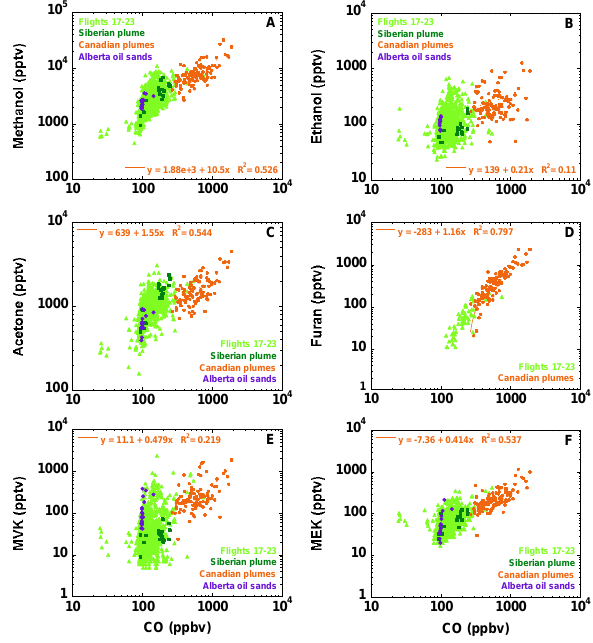
Figure 8. As in Figure 4 but for selected oxygentated compounds. MVK = methyl vinyl ketone; Fig. 8. As in Fig. 4 but for selected oxygenated compounds. MVK = methyl vinyl ketone; MEK = methyl ethyl MEK = methyl ethyl ketone.